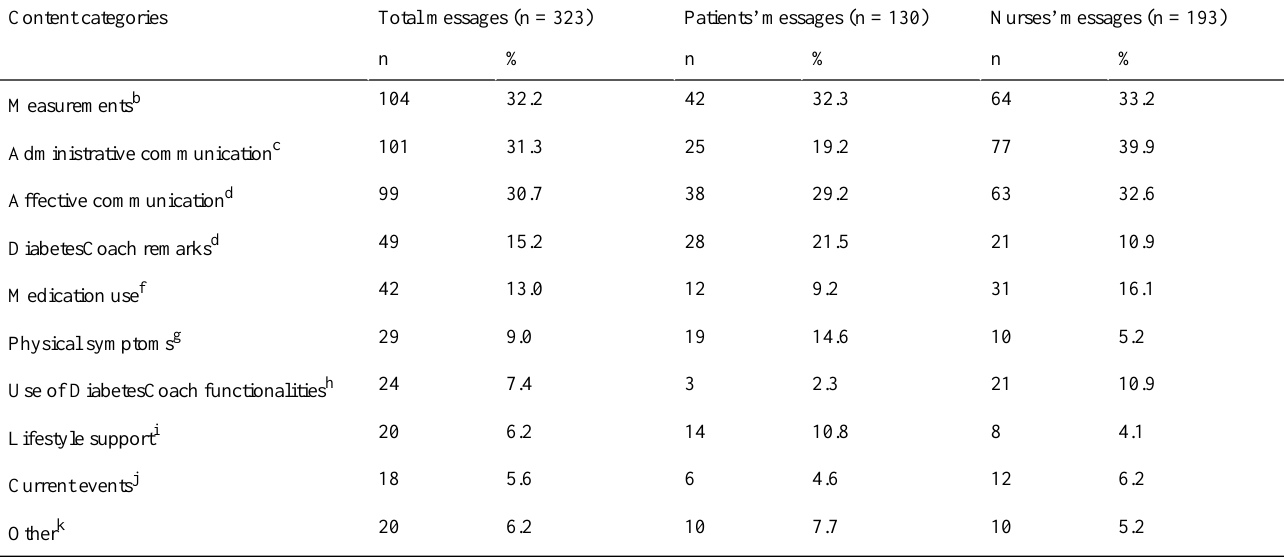
Table 3. Email message content by content category quantified by statement